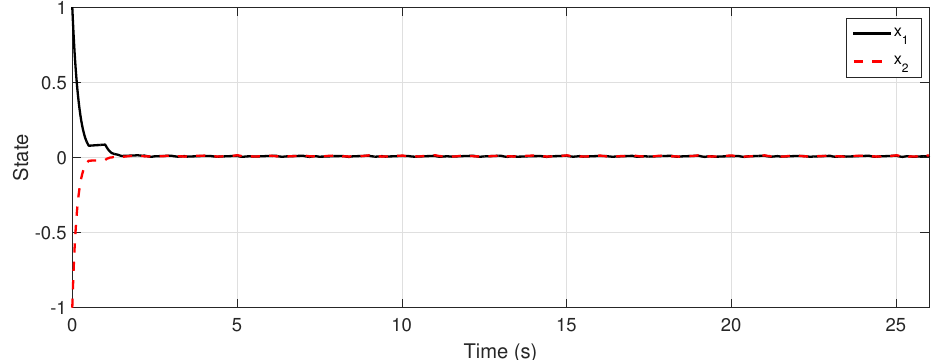
Figure 3. System trajectories, under arbitrary changes in parameters/entries of the system’s matrix and the designed switching